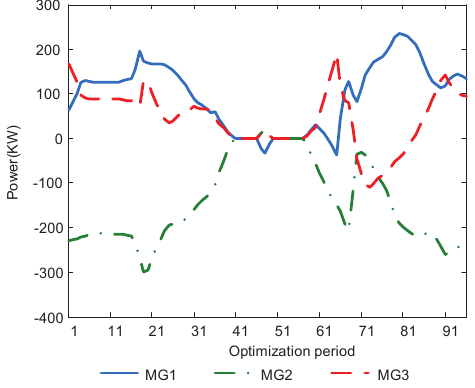
Figure 8. Decided exchange power among MGs on Day 1 of Scenario